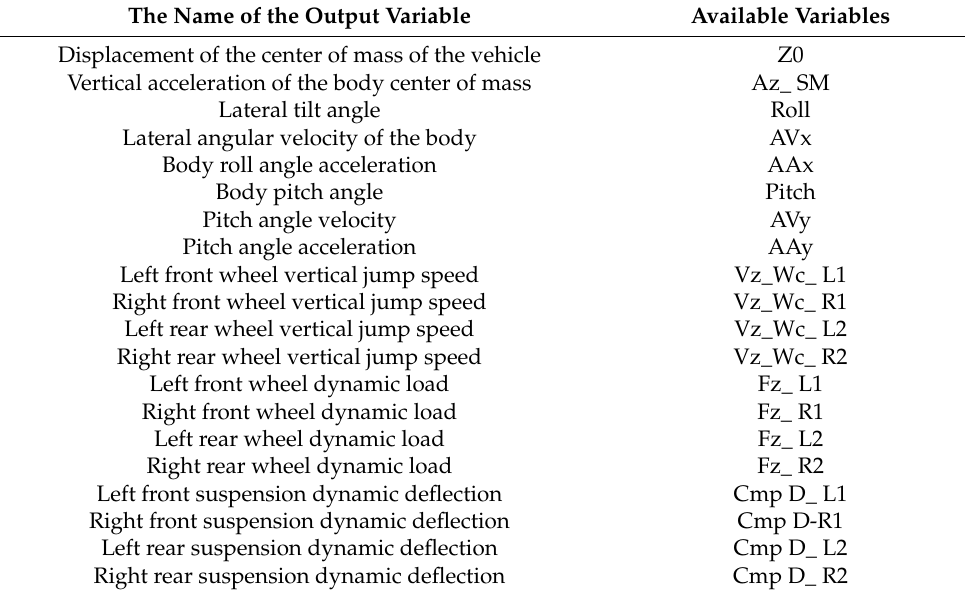
Table 4. Output variables in CarSim